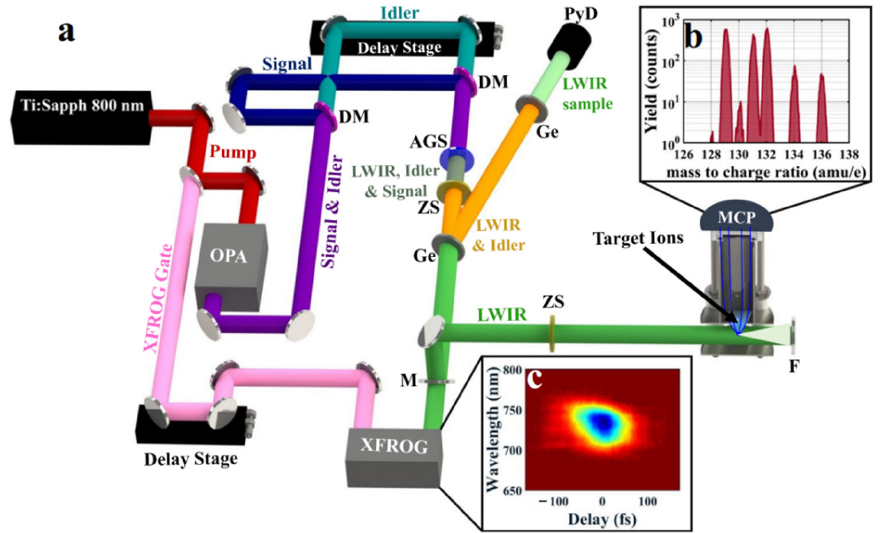
Figure 4. A DFG scheme for MIR generation tunable from 3.5 µm to 9 µm [109]. Reprinted by permission from Springer Nature Customer Service Centre GmbH: Springer Nature, Sci. Rep. , An intense, few-cycle source in the long-wave infrared., Wilson, D.J.; Summers, A.M.; Zigo, S.; Davis, B.; Robatjazi, S.J.; Powell, J.A.; Rolles, D.; Rudenko, A.; Trallero-Herrero, C.A., COPYRIGHT 2019. ( a ) a 20 mJ Ti: Sapphire 800 nm laser is used to pump an optical parametric amplifier (OPA) with 18 mJ, 26 fs pulses at 1 kHz. A total of 6 mJ signal and idler pulses are generated from the OPA, and up to 4.2 mJ are used to generate LWIR (MIR) pulses via DFG in a AgGaS 2 crystal (AGS) through type-I phase-matching. The residual pump and signal pulses are filtered by anti-reflective coated Zinc Selenide (ZS) and Germanium (Ge) windows. The Fresnel reflection of the Ge window is filtered with an additional Ge window so residual MIR power can be recorded on a pyroelectric detector (PyD) for power monitoring. A periscope sends the remaining pulse energy (>95%) into an experimental chamber with a ZS window, and then the MIR pulse is back-focused in Xenon (Xe) gas by a − 25 mm spherical concave mirror (F). A pair of electrostatic lenses guide the Xe ions onto a micro-channel plate (MCP) detector for time-of-flight measurements. A small portion of the remaining 2 mJ OPA beam (pink) is used as a gating field in the XFROG. To perform electric field characterization, Mirror M is first removed from the periscope, and then the MIR pulse is coupled into the XFROG. ( b ) A typical time-of-flight spectrum for Xe + when ionized with 8.9 µm pulse. ( c ) A measured XFROG spectrogram when the MIR laser pulse is working at 8.9 µm.